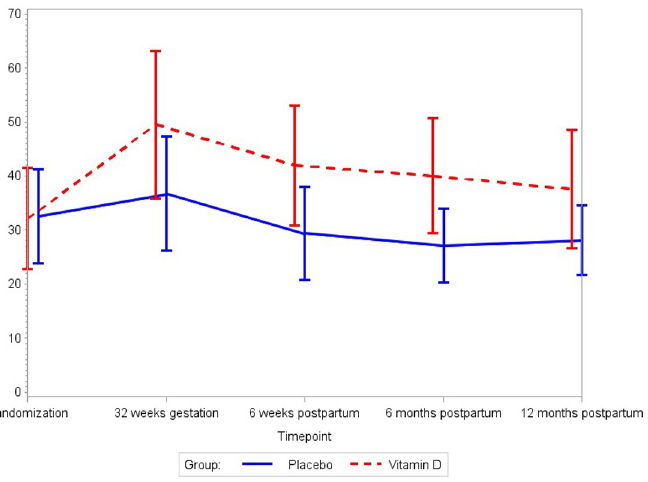
Fig 3. Effect AU : InFigs 3 and 4 : Pleaseprovidethe 25 ð OH Þ Dvaluesonthey (cid:0) axisinSIunits ð nmol = L Þ : of maternal vitamin D 3 supplementation on mean maternal serum 25(OH)D concentrations. Whiskers indicate standard deviation. p- Value for difference in trajectory for maternal serum 25(OH)D concentration < 0.001. 25(OH)D, 25-hydroxyvitamin